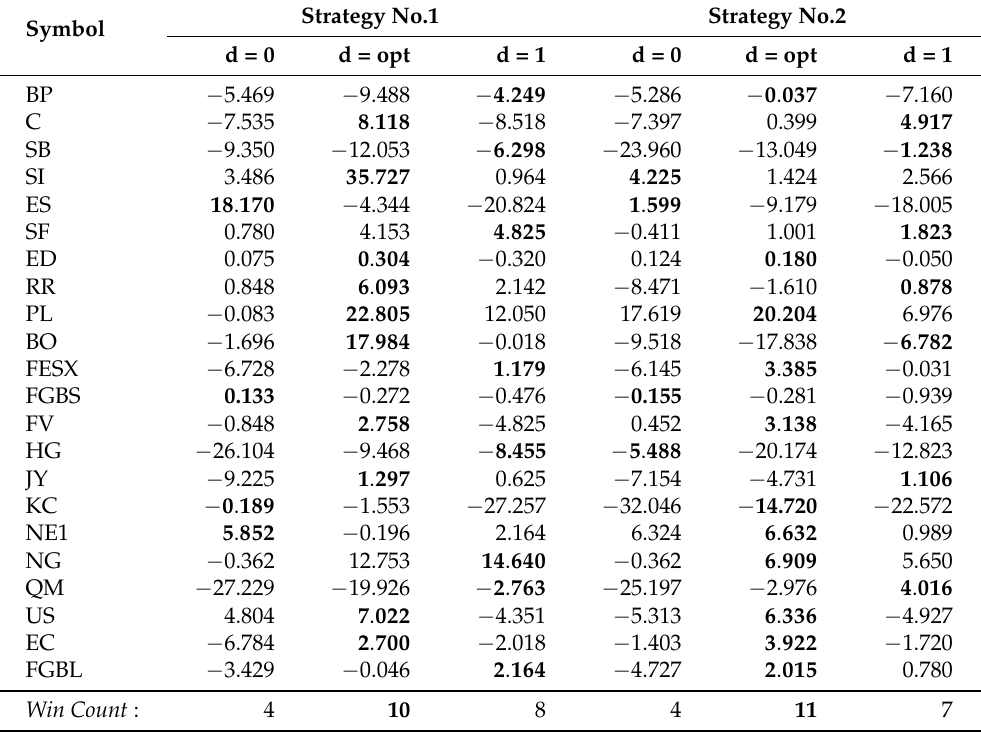
Table 6. Strategy returns using LSTM predicted prices.